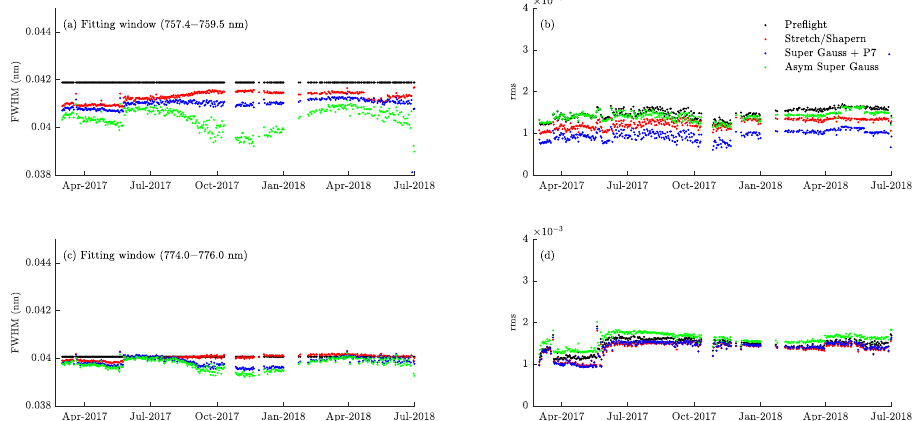
Figure 5. ( a ) FWHM and ( b ) average fitting residual of retrieved ILS using four ILS functions for the O2A band at footprint 1 and fitting window 1 over time. ( c , d ) Similar to ( a , b ) but for fitting window 6, respectively.